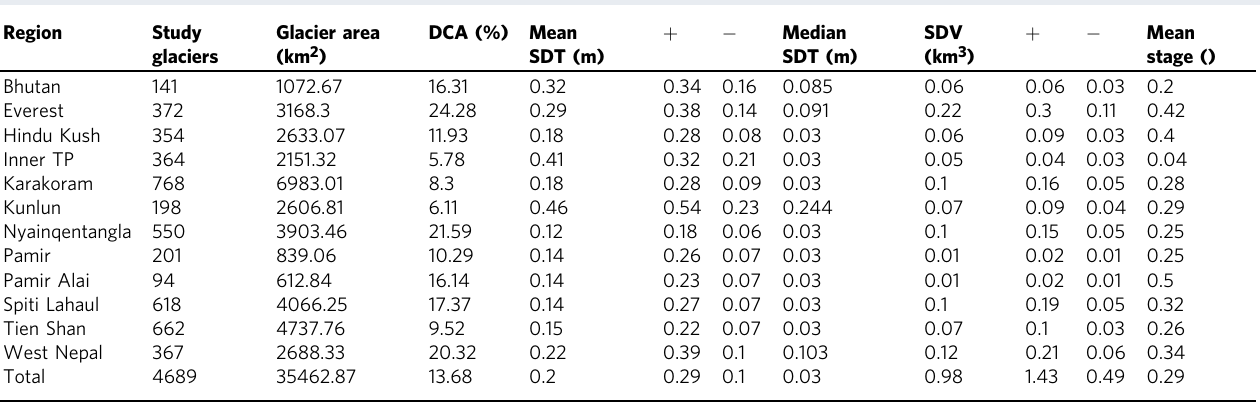
DCA debris-covered glacier area as a percentage of glacier area. + and − are one-sigma uncertainties. Stage is from ref. 1 .